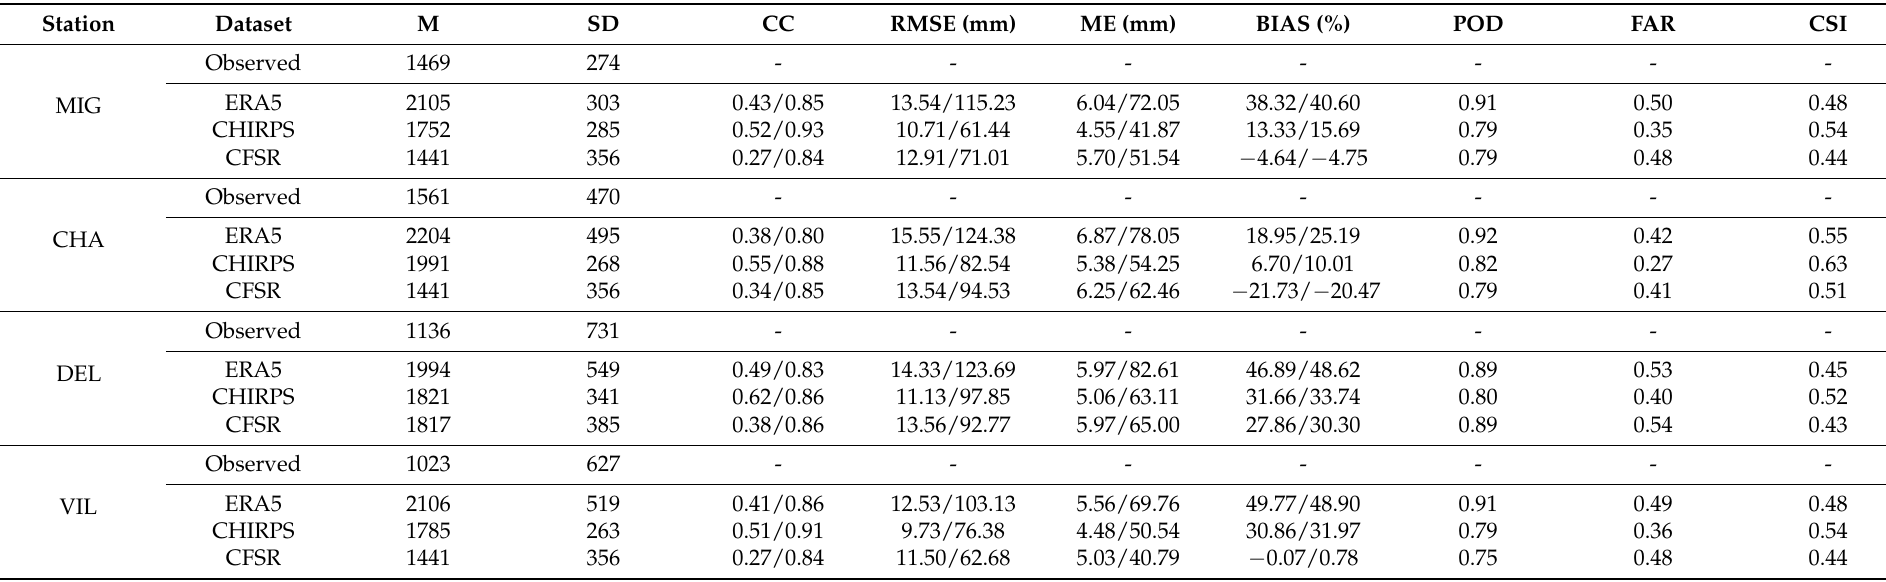
Table 3. Comparison of various validation statistics for the different reanalysis products covering the GSM River Basin. Daily and monthly statistics are shown on the left and right sides